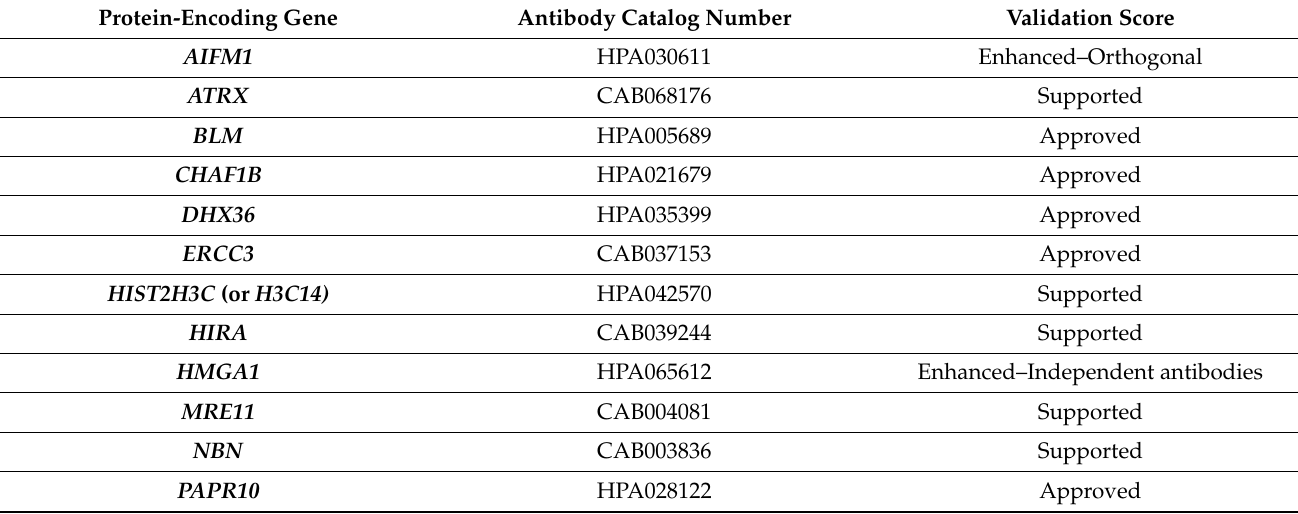
Table 2. Validation scores of antibodies selected from